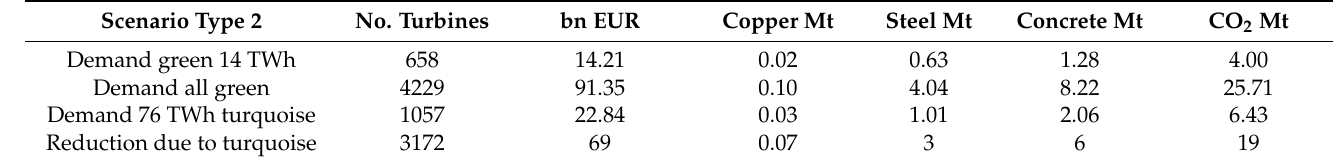
Table 4. Costs of green and turquoise hydrogen for Type 2 offshore